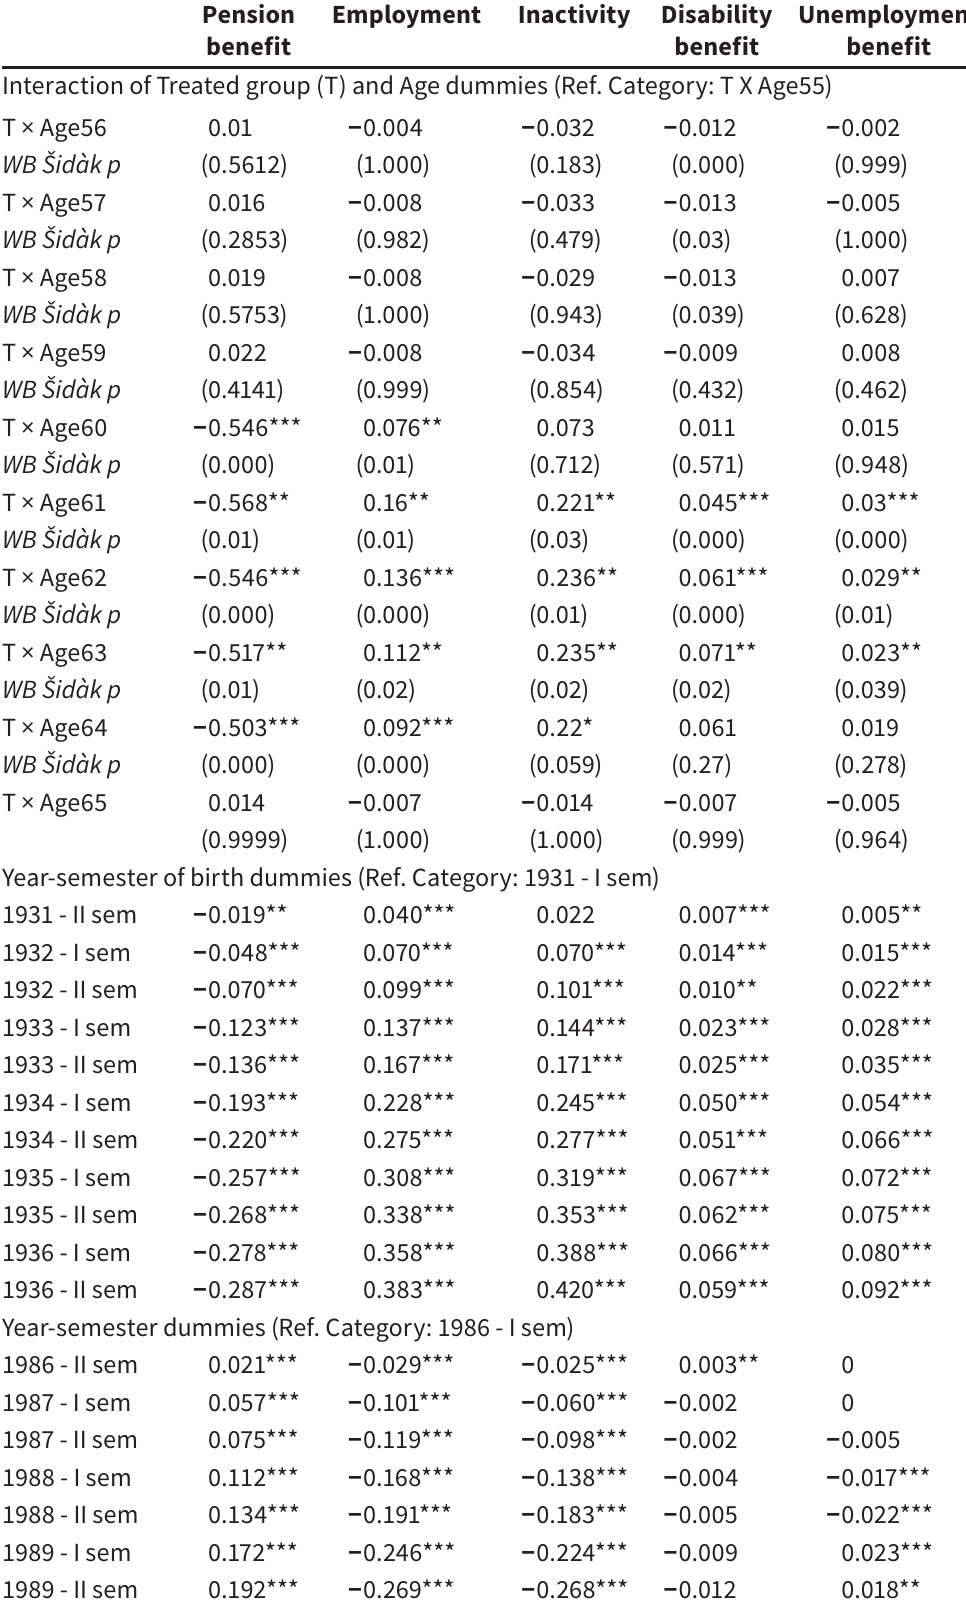
Table C1 Effect of rising the NRA on different labor market outcomes at every single age (before, during, and after the NRA rise) Eq. (1) Pension Employment Inactivity Disability Unemployment benefit benefit benefit Interaction of Treated group (T) and Age dummies (Ref. Category: T X